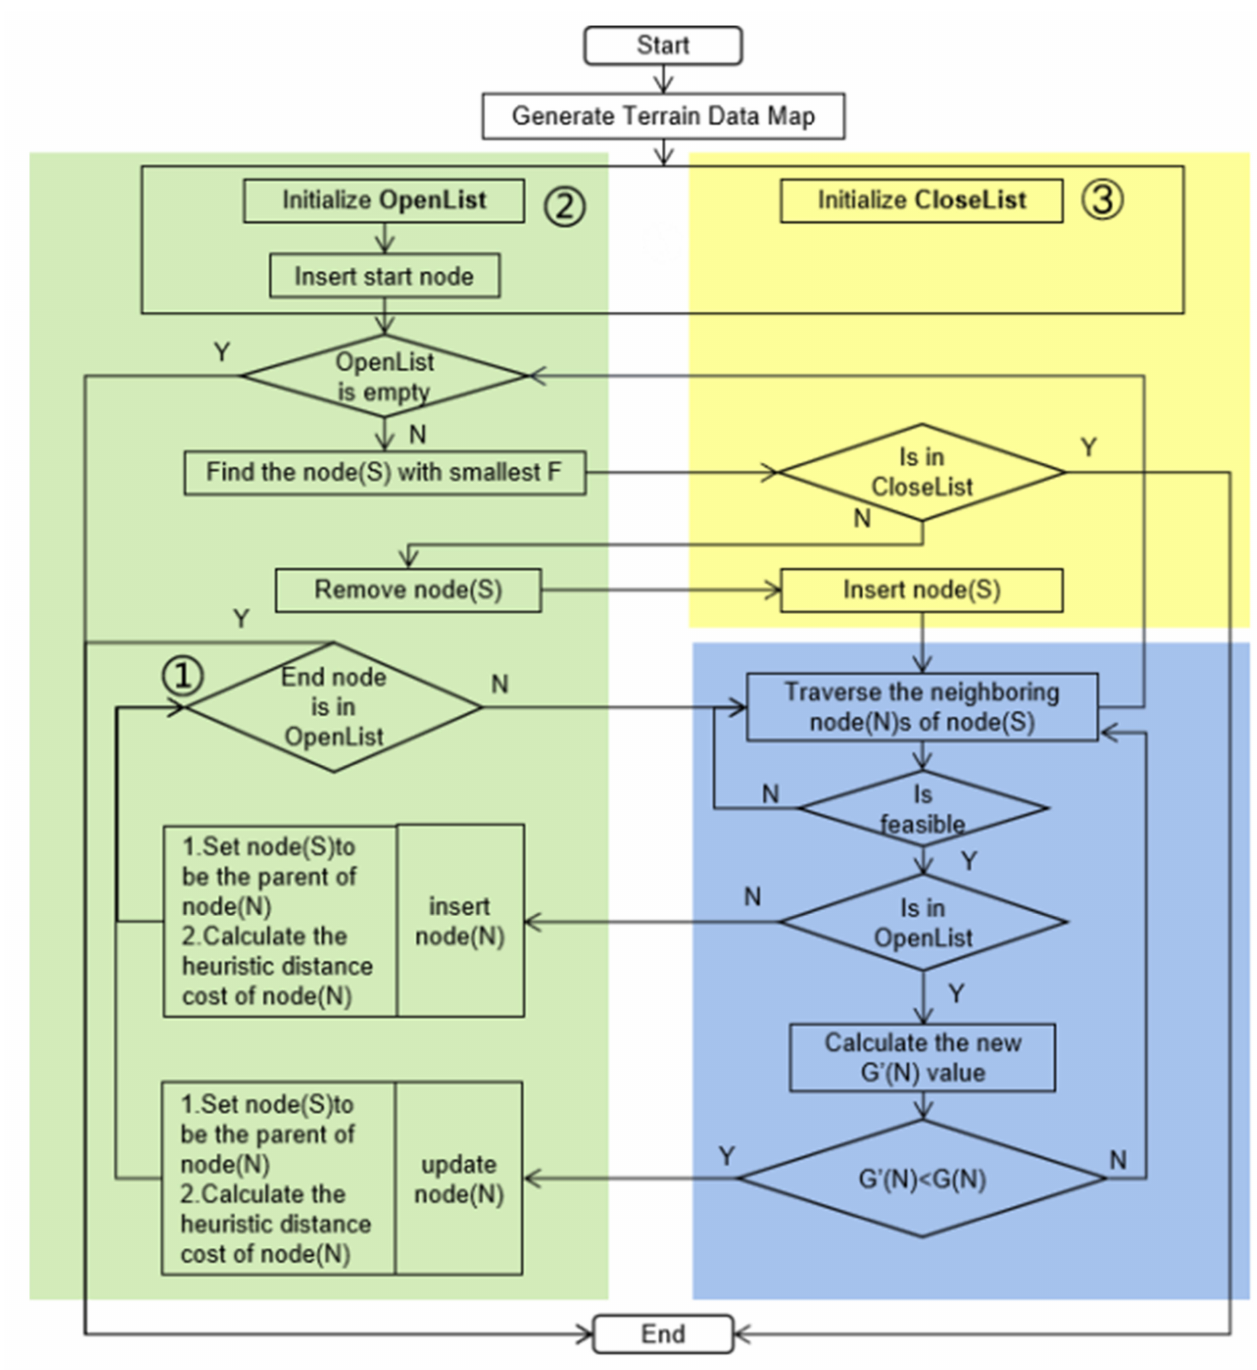
Figure 4. Improved A-Star algorithm. 1 (cid:13) – 3 (cid:13) indicate major